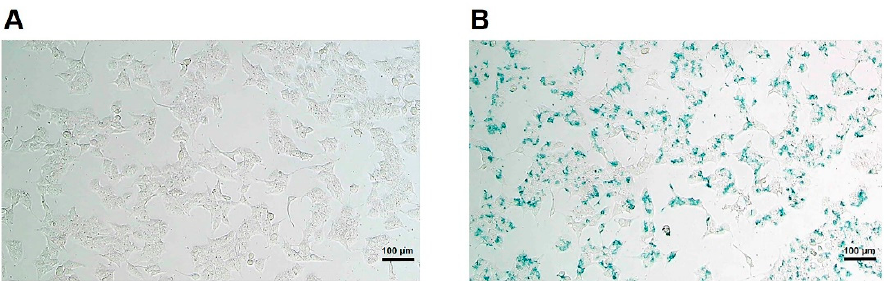
Figure 1. Uptake of chitosan-coated superparamagnetic iron oxide (CSPIO) nanoparticles by MIN6 cells. MIN6 cells were incubated overnight without ( A ) or with ( B ) CSPIO nanoparticles. The intracellular iron content was examined by Prussian blue staining.